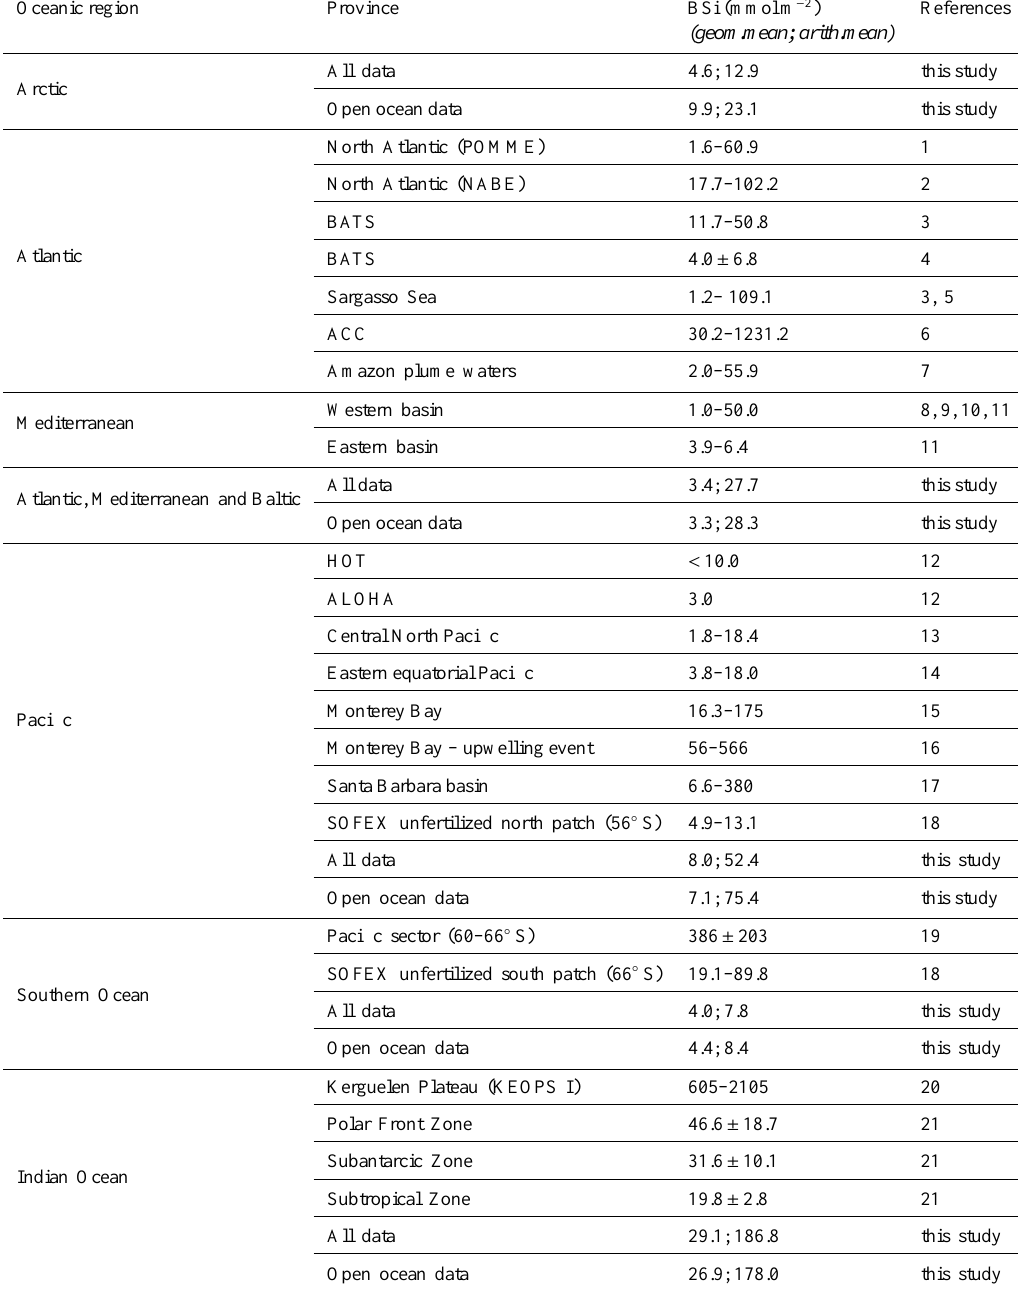
Table 6. Mean integrated BSi (over 200m) in mmolm − 2 calculated from the present database are indicated by the geometric mean and arithmetic means, using a Si:C conversion factor of 0.093 (see discussion section for calculation details). A distinction was made between all available data and open ocean data alone (considering all data points below the 100m isobath as coastal data). These results are compared to other regional data published in various studies, indicated either as minimum and maximum values or by an average ± SD. The areal surface considered for each ocean were 14.056, 76.762, 155.557, 68.556, 20.327 (in 10 12 m 2 ) for the Arctic, Atlantic + Mediterranean + Baltic, Pacific, Indian and Southern Oceans,